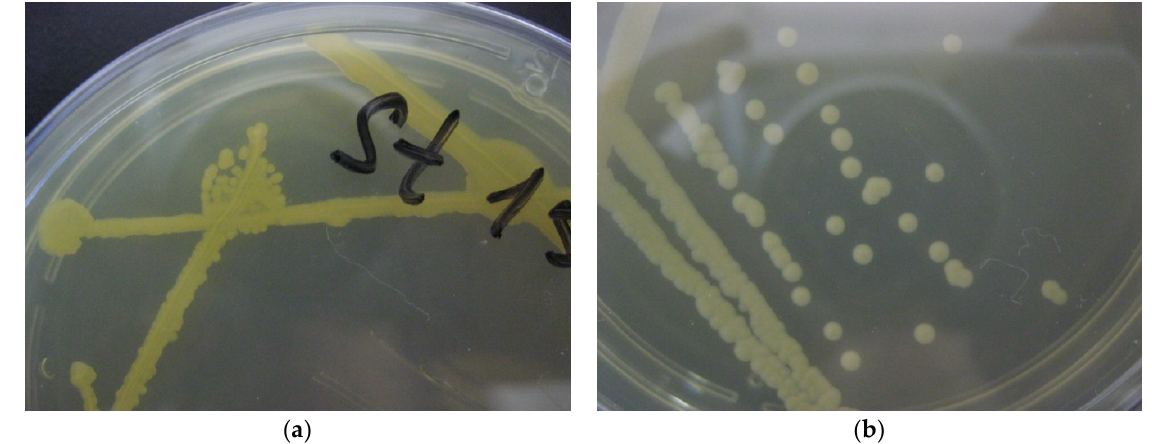
Figure 3. Typical view of a Petri dish with 1× LB agar with plated Microbacterium trichotecenolyti- cum —type 1 ( a ) and Brevundimonas diminuta —type 3 ( b ). type 1 ( a ) and Brevundimonas diminuta —type 3 ( b ).